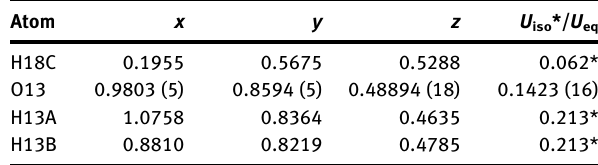
Table  : Fractional atomic coordinates and isotropic or equivalent isotropic displacement parameters (Å 